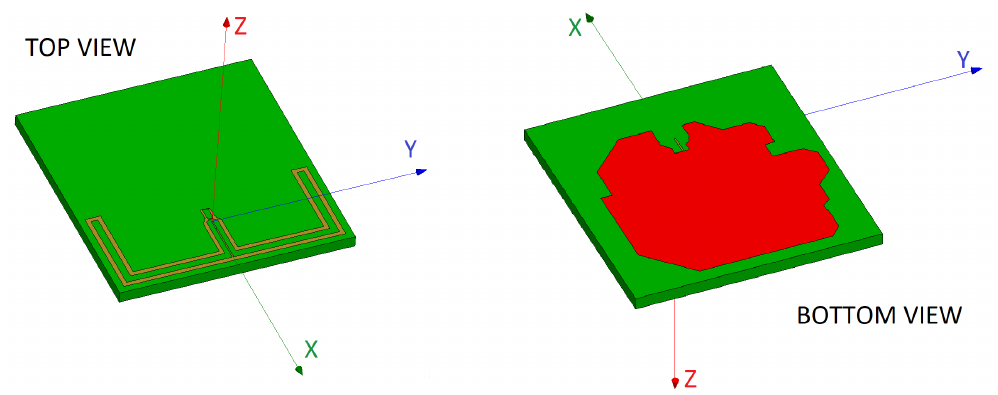
Figure 1. Example of an antenna layout considered for